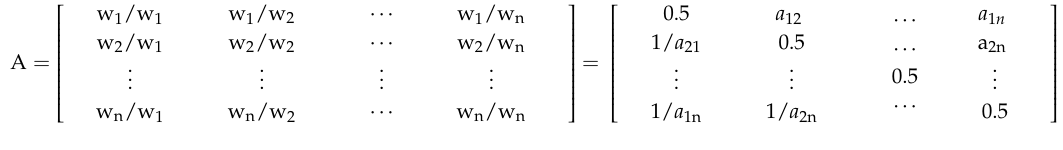
Table 1. Indications expression for the significance weight of all criteria. Bipolar Neutrosophic Numbers Scale Linguistic Expressions